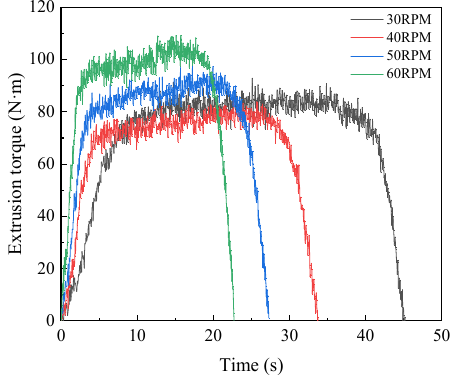
Figure 19. Influence of machine tool speed on torque.